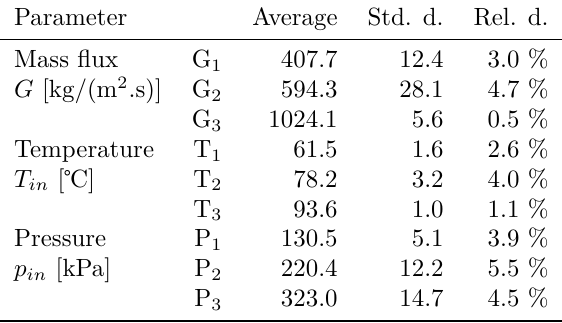
Table 2. Experimental setup of parameters with deviations from 21 runs on smooth Inconel 625 tube.